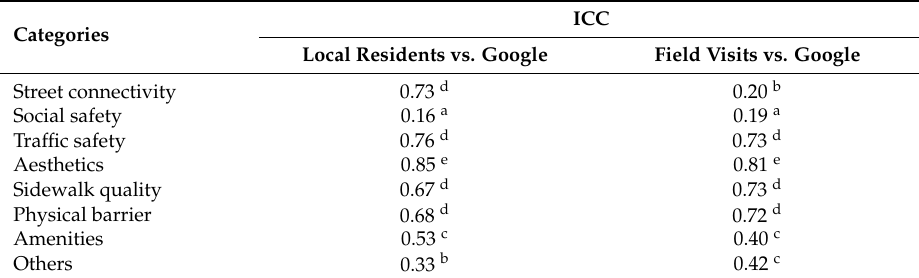
Table 3. ICC for the walkability